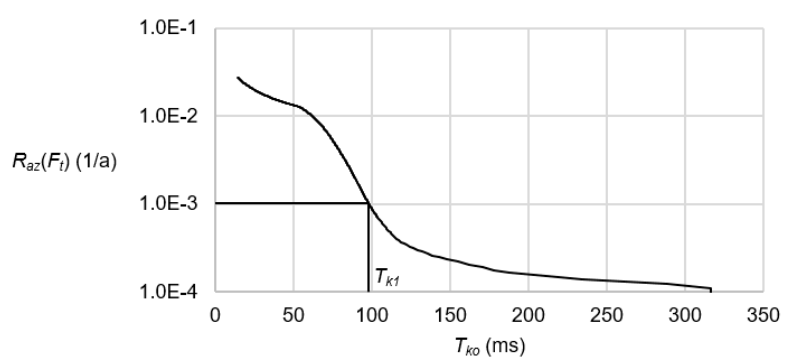
Figure 14. Risk of exceeding force F t versus T ko (assumed for F t calculations) under short circuit conditions at point A for configuration No. 1.